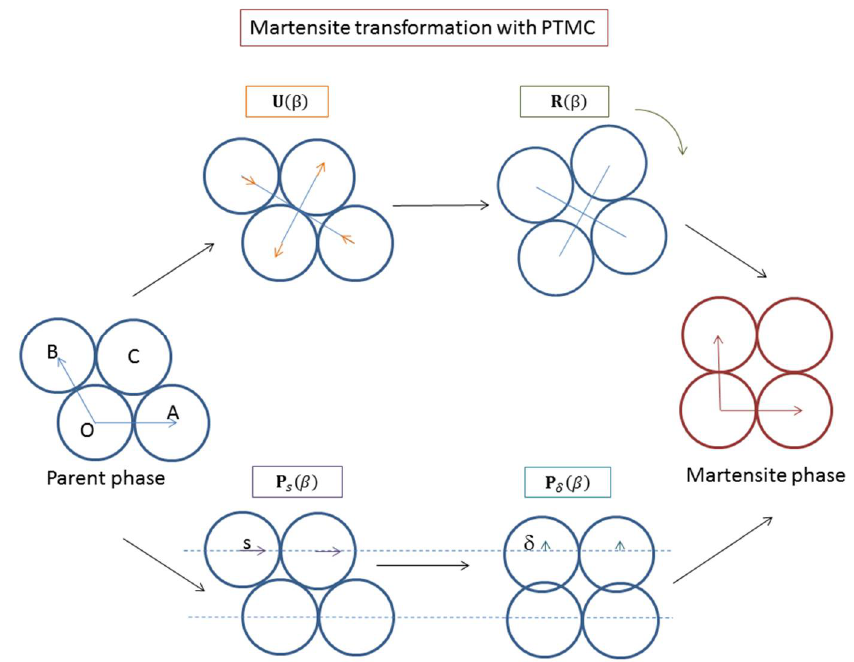
Figure 16. Hexagonal–square transformation with PTMC.